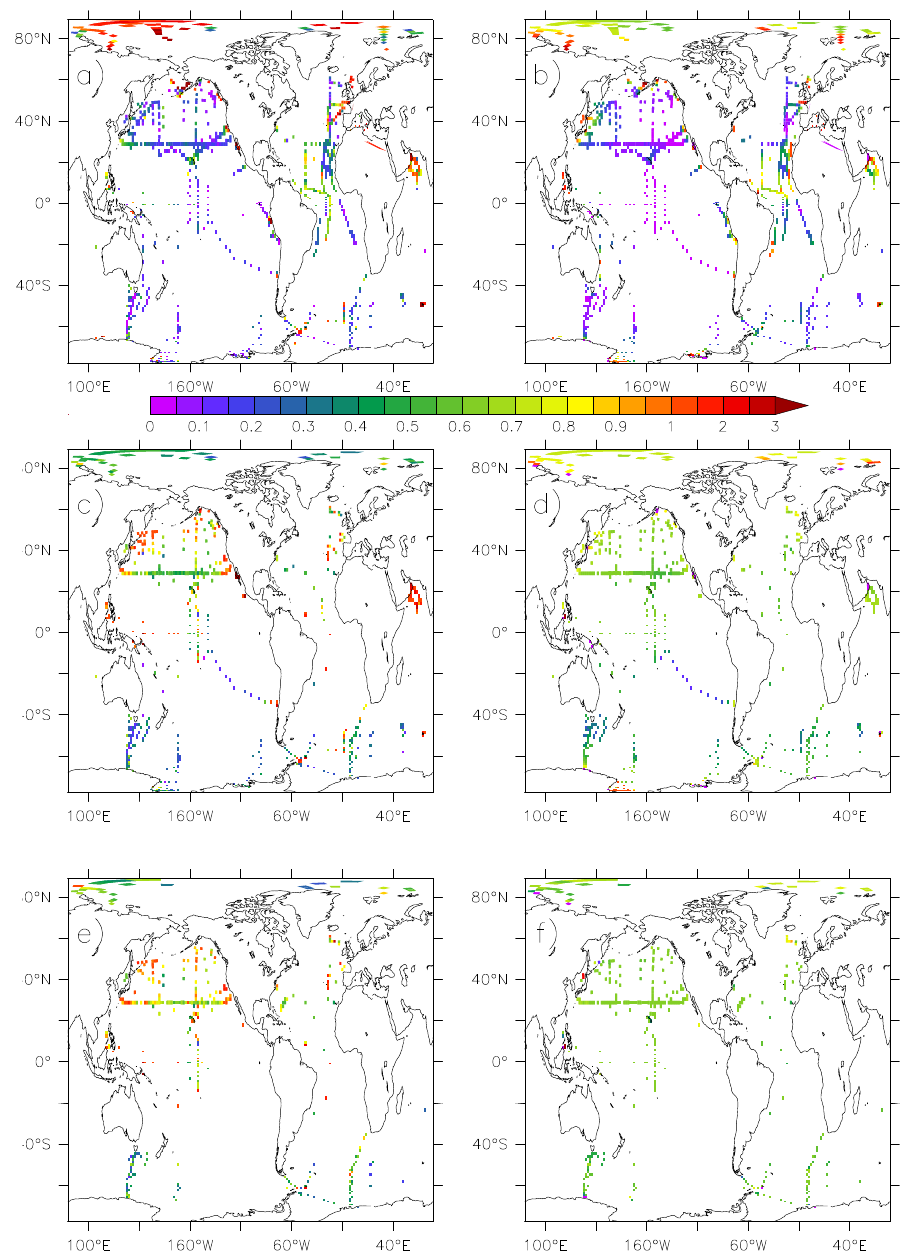
Figure 8. Spatial distribution of annual-mean iron concentrations (in nmolL − 1 ) as observed (left column) and as simulated by PISCES (right column). On panels (a) and (b) , iron has been averaged over the top 50m of the ocean. On panels (b) and (c) , iron has been averaged over 200–1000m. The bottom two panels display the iron distributions average over the depth range 1000–5000m. Model values have been sampled at the same location and month as the